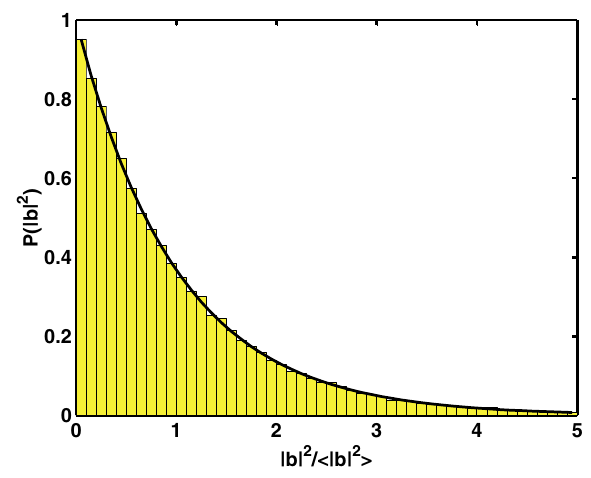
FIG. 2. (Color) The probability distribution P (cid:6)j b j 2 (cid:7) for the ensemble of 10 5 macroparticle distributions as a histogram. The solid line is the negative exponential distribution function of mean equal to 1.